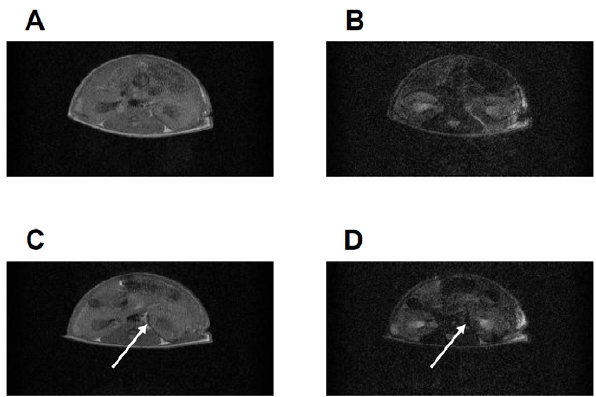
Figure 4. In vivo MRI of transplanted islets labeled with TMADM-03. A. T1-weighted images of unlabeled islets (1000 IEs) transplanted into the left kidney capsule. B. T2-weighted images of unlabeled islets (1000 IEs) transplanted into the left kidney capsule. C. T1-weighted images of islets (1000 IEs) that were labeled with TMADM- 03 and transplanted into the left kidney capsule. D. T2-weighted images of islets (1000 IEs) that were labeled with TMADM-03 and transplanted into the left kidney capsule. The arrows show transplanted grafts.